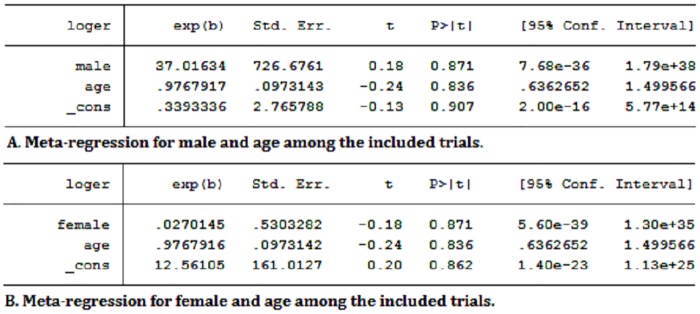
Meta-regression for gender and age.